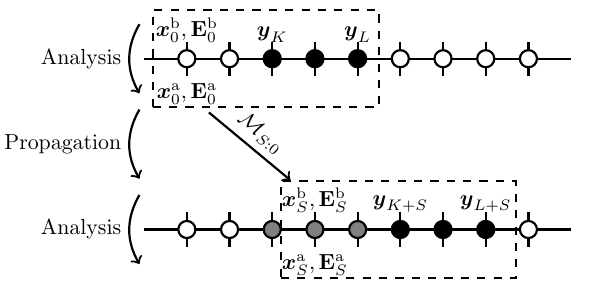
Figure 2. Chaining of the 4D-Var and IEnKS first two cycles with S = 3 ,L = 4. The first 4D-Var analysis uses the background x b and the observations y L : K to give the analysis x a agated S steps forward in time to produce the new background at time t S where another analysis can be performed. The IEnKS does the same but with an ensemble. The dashed rectangle symbolizes the current DAW, black dots represent the observations assimilated in the current cycle, gray dots represent already assimilated obser- vations and white dots represent observations not